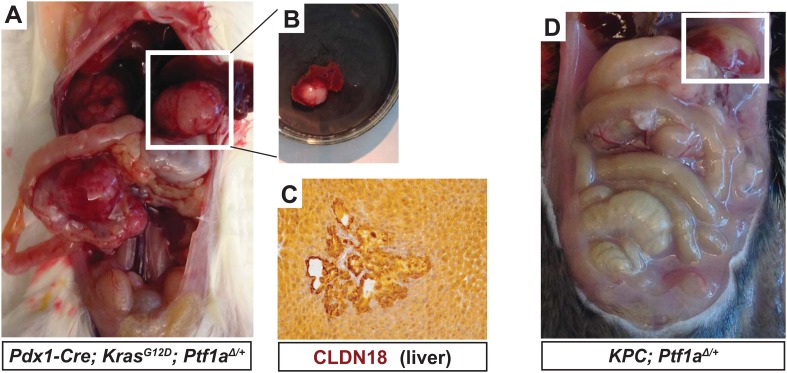
Liver metastases in KPC mice heterozygous for Ptf1a.(A) Gross image of a Pdx1-Cre; KrasG12D; Ptf1a+/− mouse harboring metastatic pancreatic cancer. White box highlights large liver metastasis. (B) Dissected lobe of the liver with pancreatic liver metastasis. (C) IHC for CLDN18 confirmed liver metastases in a subset of Pdx1-Cre; KrasG12D; p53+/−; Ptf1a+/− mice. (D) Gross image of Pdx1-Cre; KrasG12D; p53+/−; Ptf1a+/− mouse harboring metastatic PDAC. White box highlights liver metastasis.